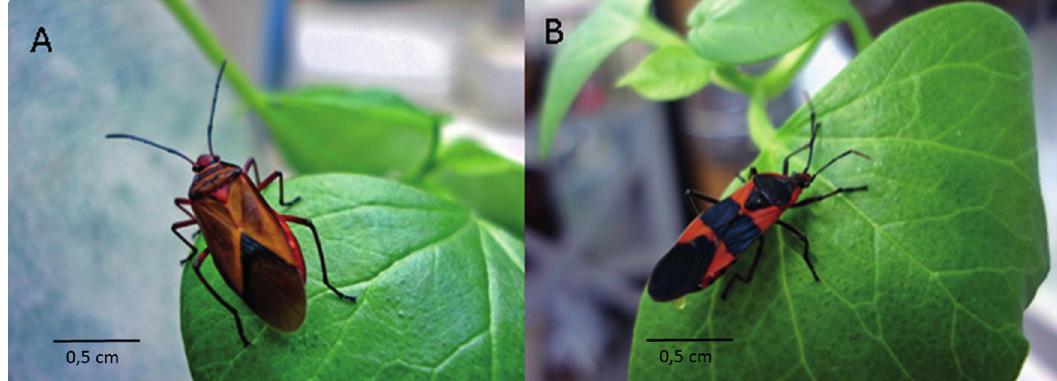
Figure 4 - Adults of: ( a ) Dysdecus peruvianus and ( b ) Oncopeltus fasciatus . The bar is equal to 1.2 cm. Photos Saulo Rigon e Felipe